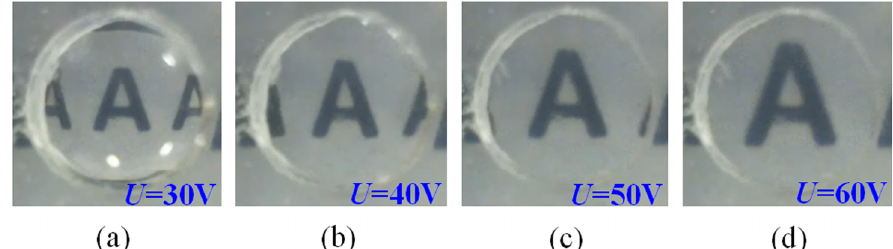
Figure 4. Images for different focal lengths under different voltages: ( a ) Initial state; ( b ) State 1; ( c ) State 2; ( d ) State 3.